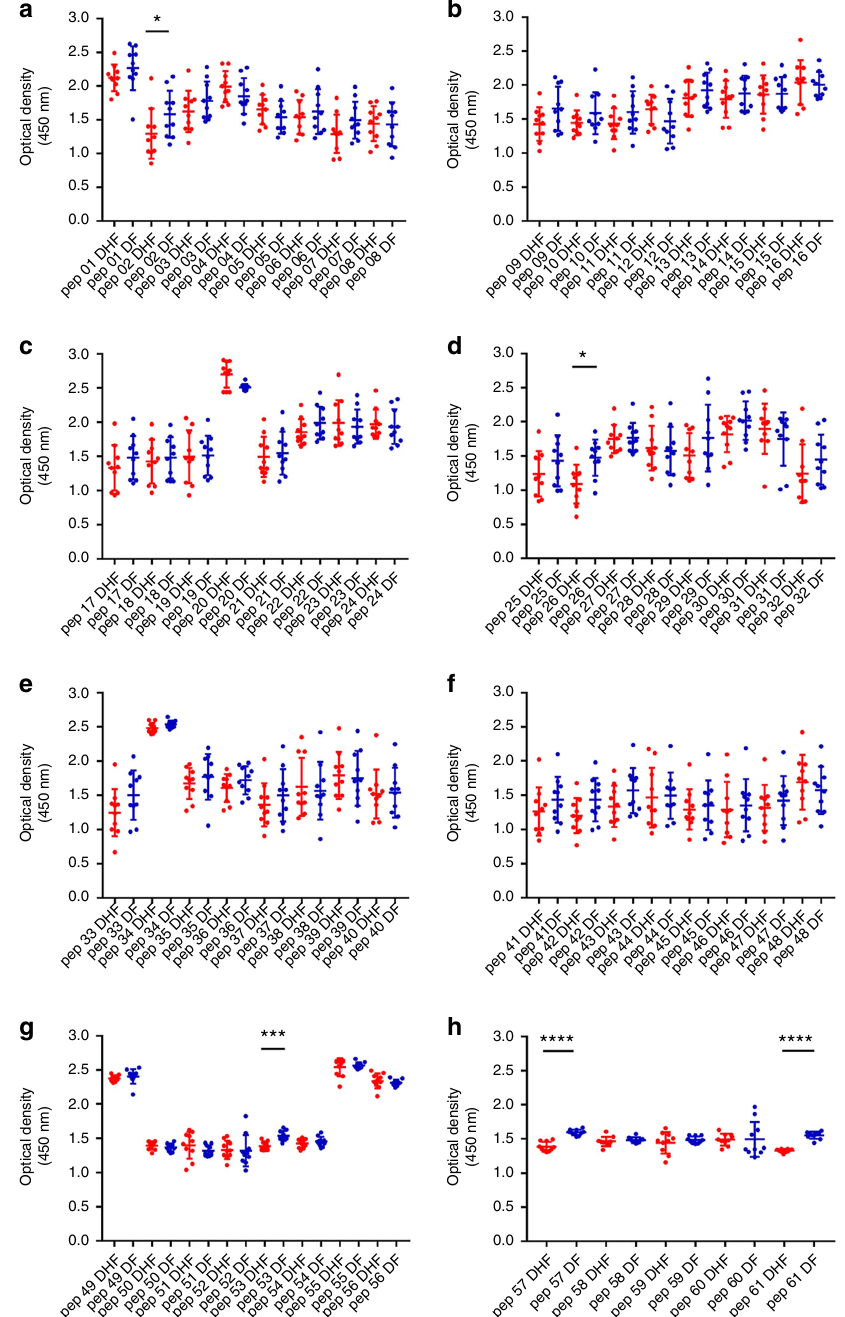
Fig. 3 DENV1 NS1 antibody responses to NS1 peptides in the febrile phase. a – h DENV1 NS1-speci fi c IgG antibody responses to 61 DENV1 NS1 overlapping peptides in patients with DF ( n = 10) and DHF ( n = 10) were measured by ELISA on day 4 of illness. Differences in mean values between antibody responses to overlapping peptides in patients with DF and DHF were compared using the Mann – Whitney U test (two tailed). NS1 antibody levels in patients with DHF are indicated in red, and in those with DF in blue. Error bars indicate mean and standard deviation (SD). * P < 0.05, ** P < 0.01, *** P < 0.001, **** P <